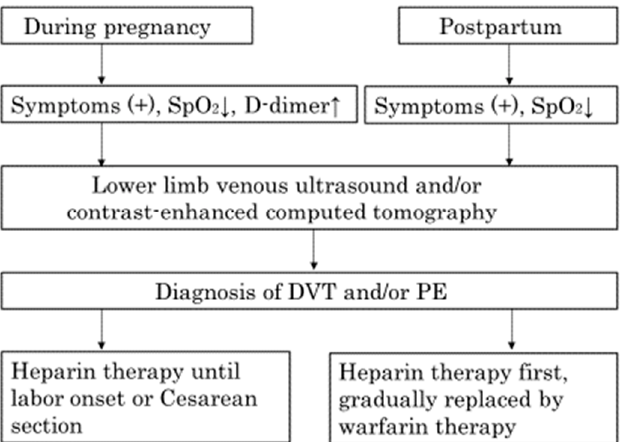
Figure 1. A flow diagram showing the process of diagnosis and treatment of patients with DVT and/or PE. Symptoms include dyspnea, chest pain and leg pain etc. SpO 2 = peripheral oxygen saturation, DVT = deep venous thrombosis, PE = pulmonary embolism.